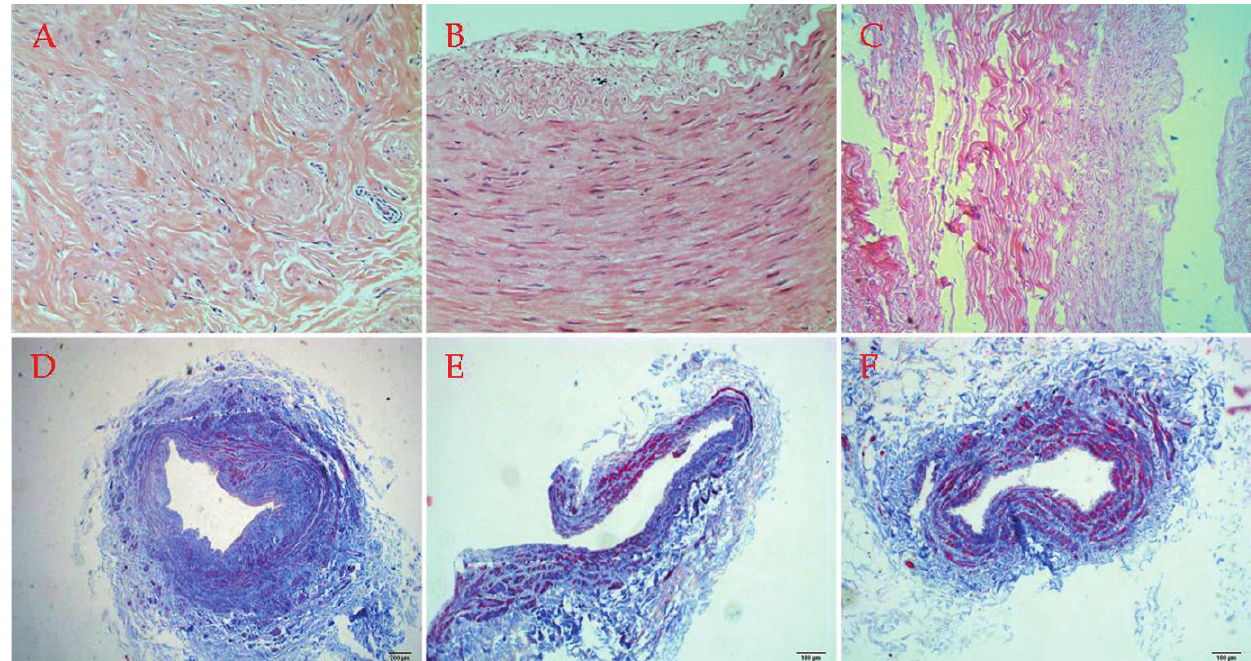
Figure 1 - Hematoxylin and eosin staining showing (A) proliferative medial smooth muscle cells with inflammatory cell infiltration in the saphenous veins, (B) focal intimal degeneration with slight disrupted media in the radial arteries, and (C) roughly normal vascular wall structures of the internal mammary arteries; H&E 6 200. Masson’s trichrome staining showing that (D) the saphenous veins showed more collagen deposition but less muscular fibers, (E) the radial arteries showed less collagen deposition and more muscular